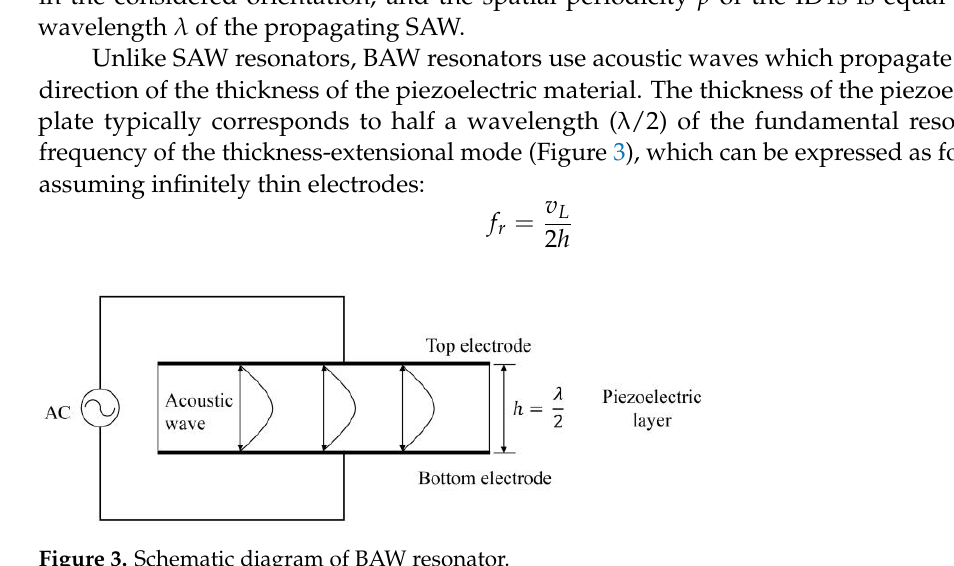
Figure 3. Schematic diagram of BAW resonator.